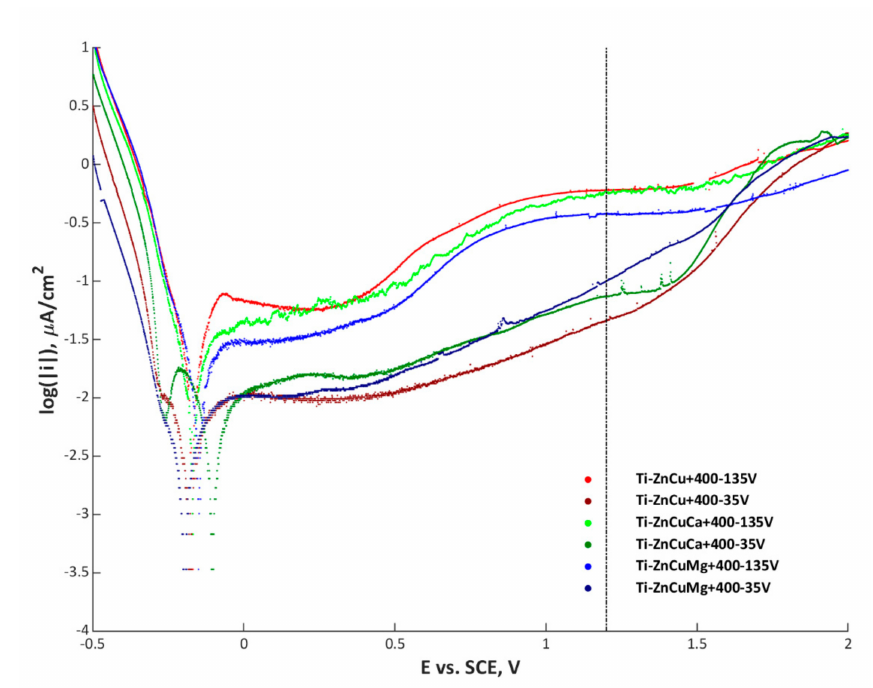
Figure 12. Polarization curves of fabricated